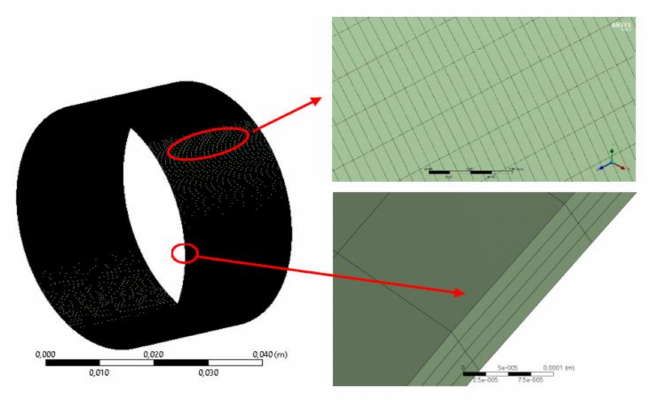
Figure 3. Schematic of grid generation for computational fluid dynamics- (CFD-) based thermo- hydro-dynamic